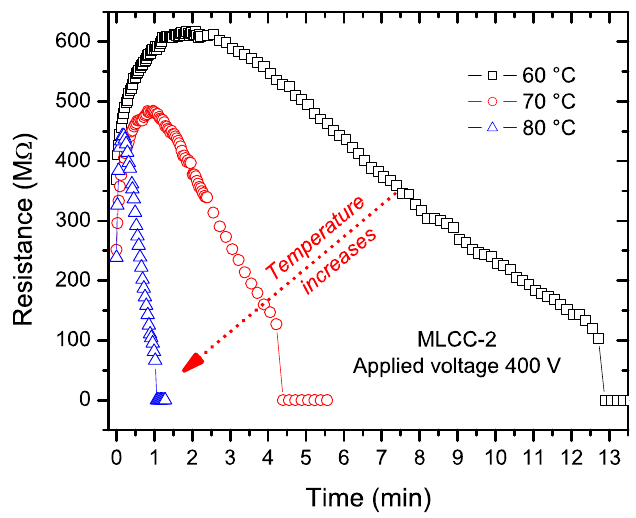
Figure 8. Change in the resistance value of an MLCC-2 at temperatures below 80 °C and 400 V. All three samples exhibit an initial increase in the resistance values, followed by a decrease, before breakdown.